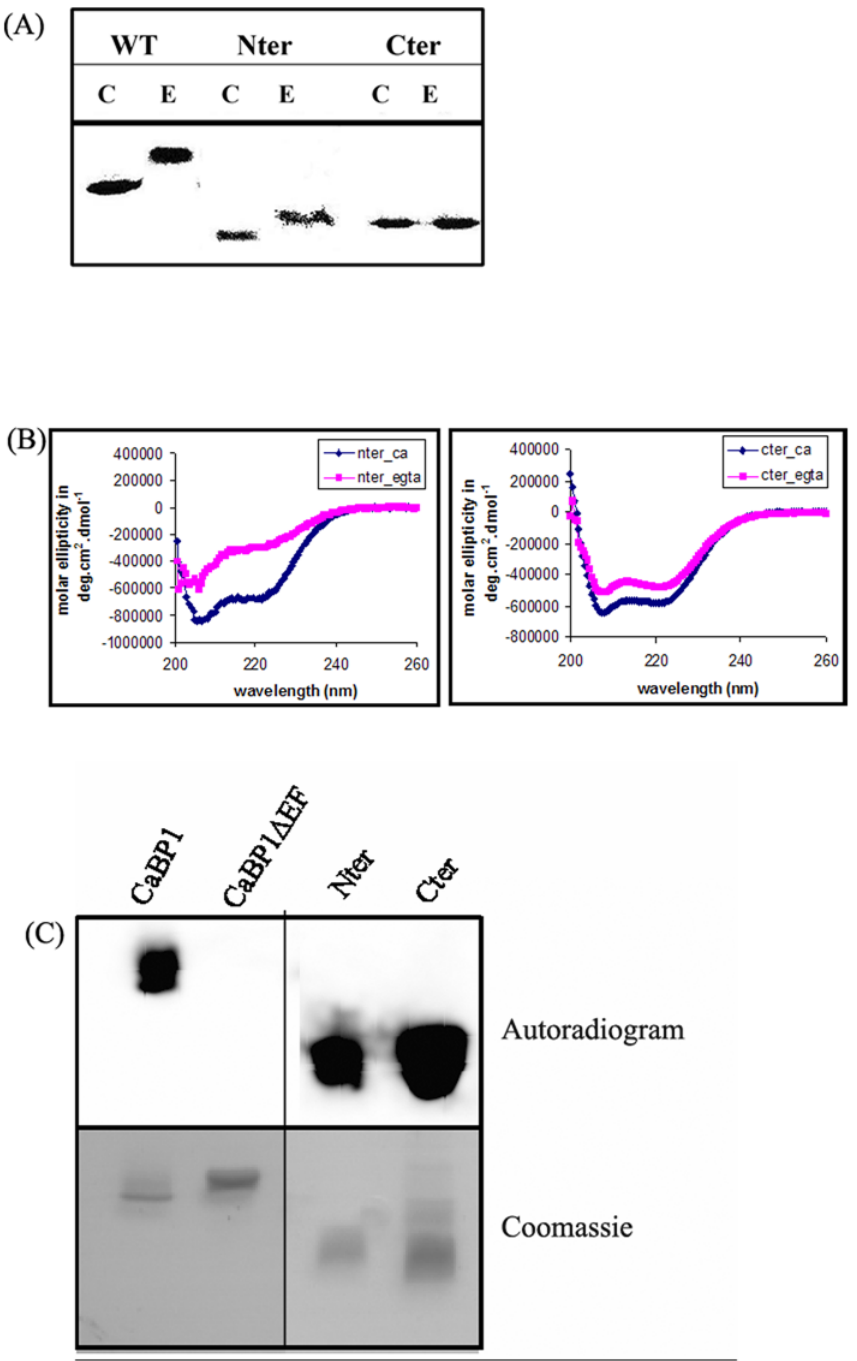
Figure 2. Characterization of Ca 2 + binding property of the EhCaBP1 domains. (A) Gel mobility shift of Ca 2 + -bound and Ca 2 + - free forms of EhCaBP1 (WT) and respective domains. Recombinant proteins are purified from E. coli lysates expressing EhCaBP1 WT or indicated domains. Five micrograms of purified proteins (as indicated) are subjected to electrophoresis on a 15% SDS-PAGE in presence of 5 mM Ca 2 + (C) or 2 mM EGTA (E). The proteins are stained with Coomassie Brilliant Blue R-250. (B) Far UV spectra of EhCaBP1 domains in presence and absence of Ca 2 + are shown separately. (C) Ca 2 + binding by the domains is also checked by 45 Ca overlay assay. The figure represents an autoradiogram (upper panel) and the corresponding SDS-PAGE gel is stained with Coomassie Brilliant Blue R-250. CaBP1 D EF, a Ca 2 + insensitive mutant of EhCaBP1 [9] was used as a negative control. The vertical line indicates that few unwanted lanes have been deleted from the gel picture.